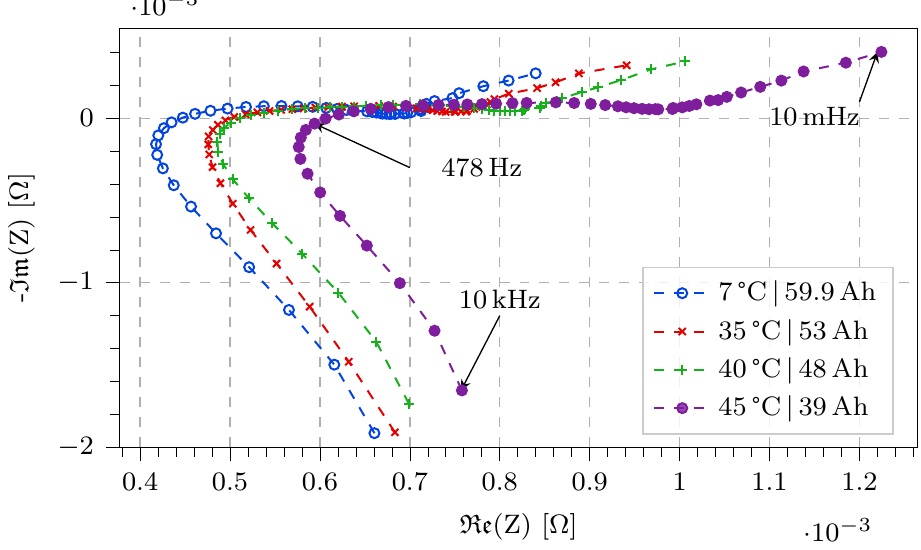
Figure 6. Nyquist plot of impedance of cells stored at the same SoC ( 50% ) after 13 months. Mea- surements performed at 50% SoC and 25°C. In the legend, the leftmost column represents storage temperature, and the rightmost column shows the maximum available